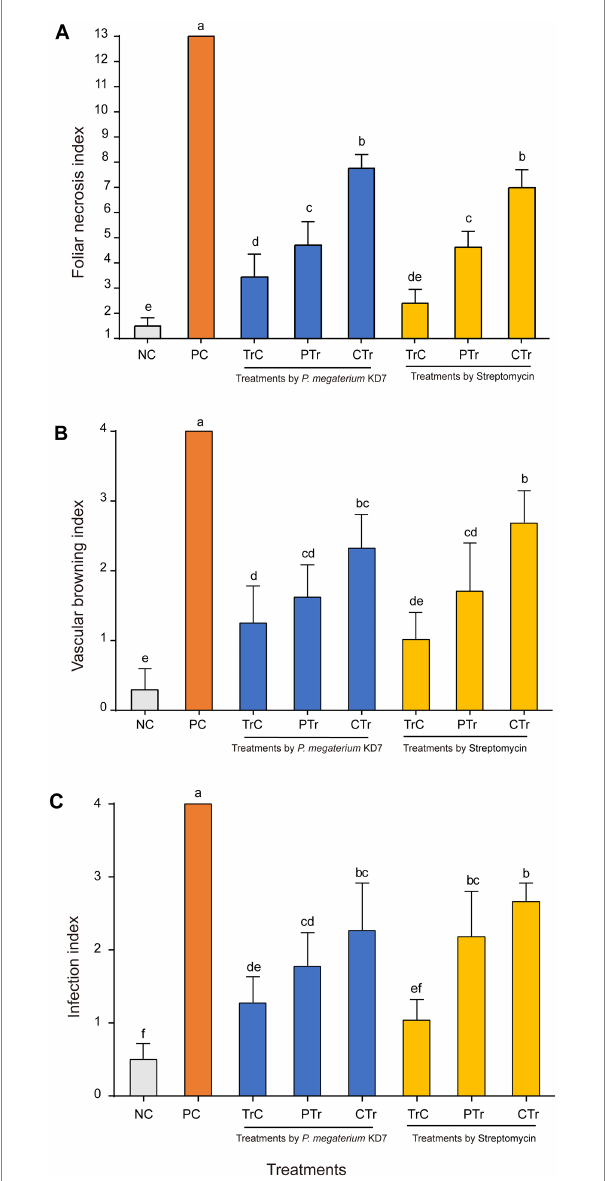
FIGURE 6 The disease index of fire blight in detached pear tissues treated with P. megaterium strain KD7 after 15 days post-inoculation (dpi): (A) leaves, (B) twigs and (C) fruits. NC, negative control; PC, positive control; TrC, treatment control; PTr, protective treatment; CTr, curative treatment. Means with the same letter are not significantly different at p ≤